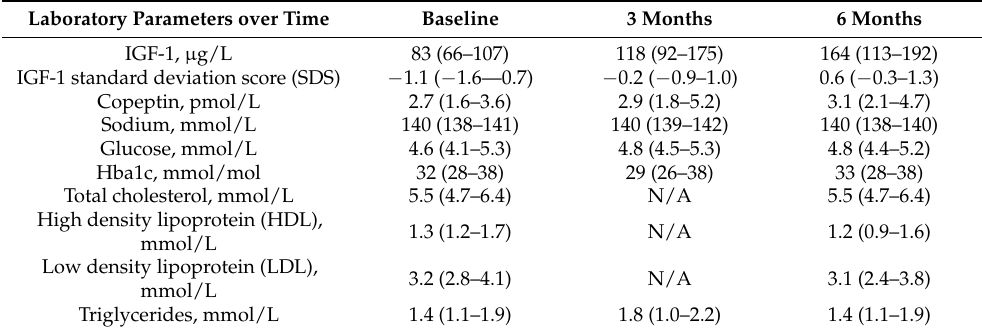
Table 2. Laboratory parameters over time of 33 patients with growth hormone (GH) deficiency.